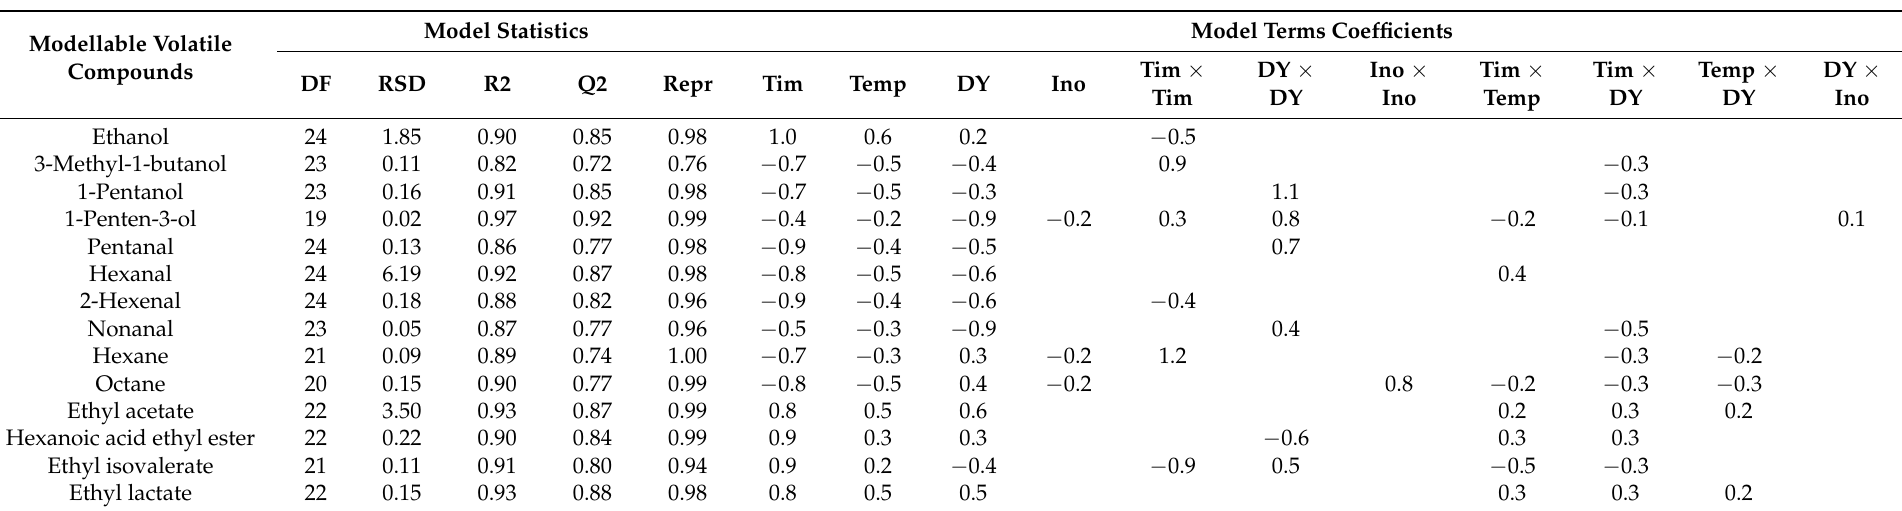
Table 3. Model statistics and terms’ coefficients of the modellable volatile compounds (R2 > 0.8, Q2 > 0.7). Number of observations n =